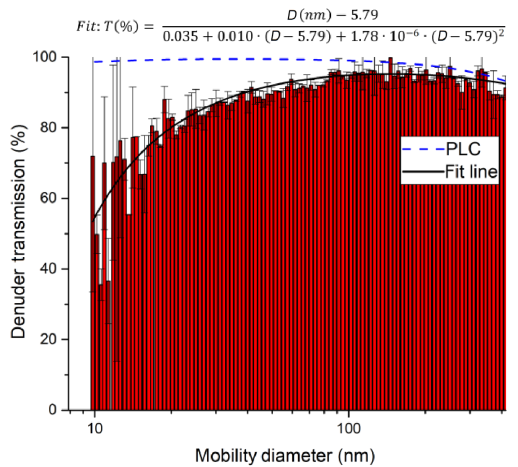
Figure 5. Transmission of ammonium nitrate particles through the denuder inlet. Relative transmissions are derived by dividing the number size distribution when sampling through the denuder by a size distribution obtained without the denuder. Error bars are based on the standard deviation of three consecutive measurements with and without the denuder. An aerosol flow of 3.3slpm was directed through the denuder (diameter 3cm, see Sect. 2.4), and a DMA sub- sequently sampled 0.3slpm from the stream exiting the denuder. The plot also includes a fit of the experimental (solid, black line) data and a theoretical transmission distribution computed with the Particle Loss Calculator (PLC).